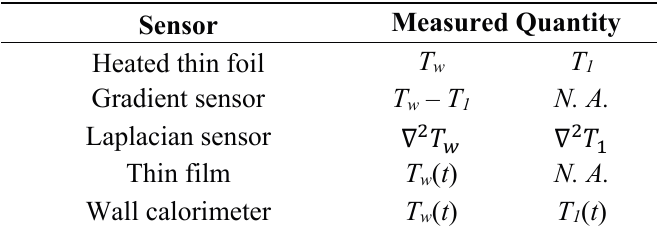
Table 1. Quantities to be measured in the various heat flux